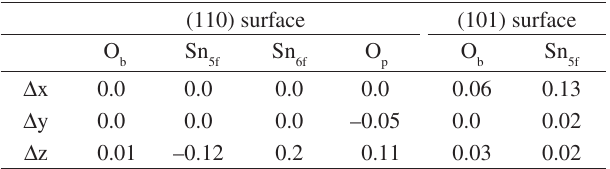
thin film. a) Obtained by 2